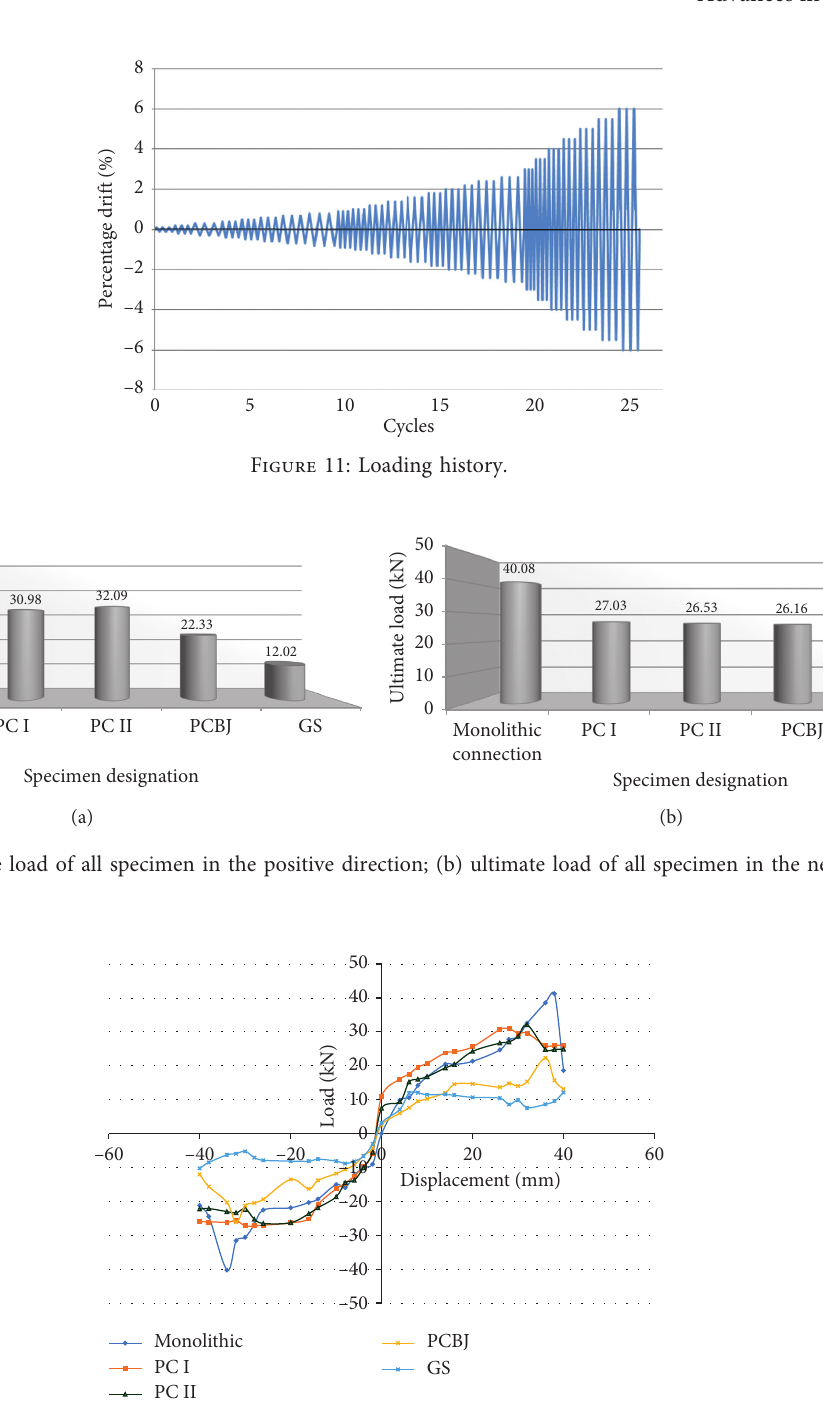
Figure 13: Load-displacement envelope of all